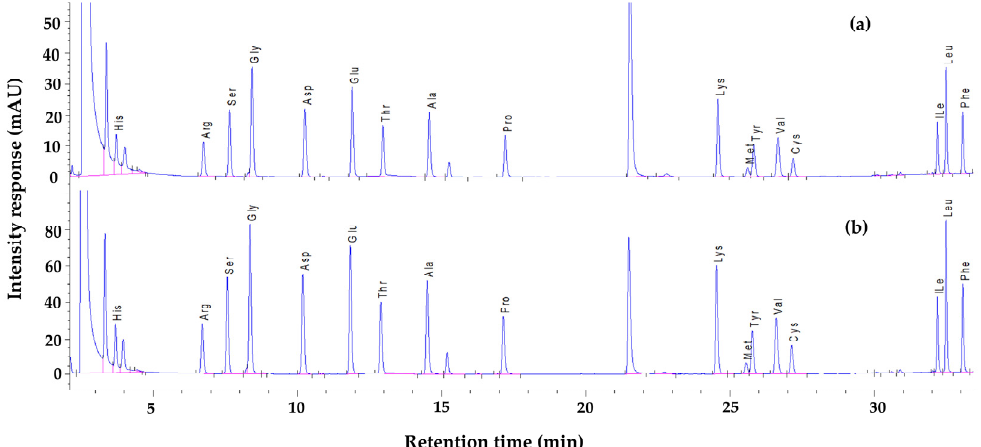
Figure 2. Representative chromatograms corresponding to the AA profiles of ( a ) fresh SBLs and ( b ) freeze-dried SBLs. Ala: alanine; Arg: arginine; Asp: aspartic acid; Glu: glutamic acid; Gly: glycine; His: histidine; ILe: isoleucine; Leu: leucine; Lys: lysine; Met: methionine; Phe: phenylalanine; Pro: proline; Ser: serine; Thr: threonine; Tyr: tyrosine; Val: valine; Cys: cysteine + cystine.